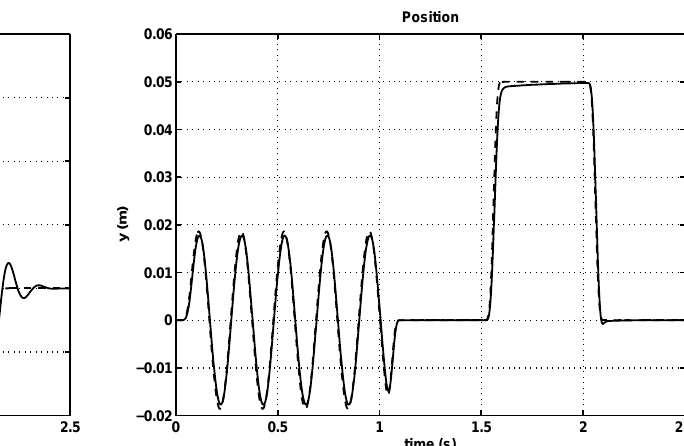
Figure 5: Position tracking with the controller of sec- tion 3.